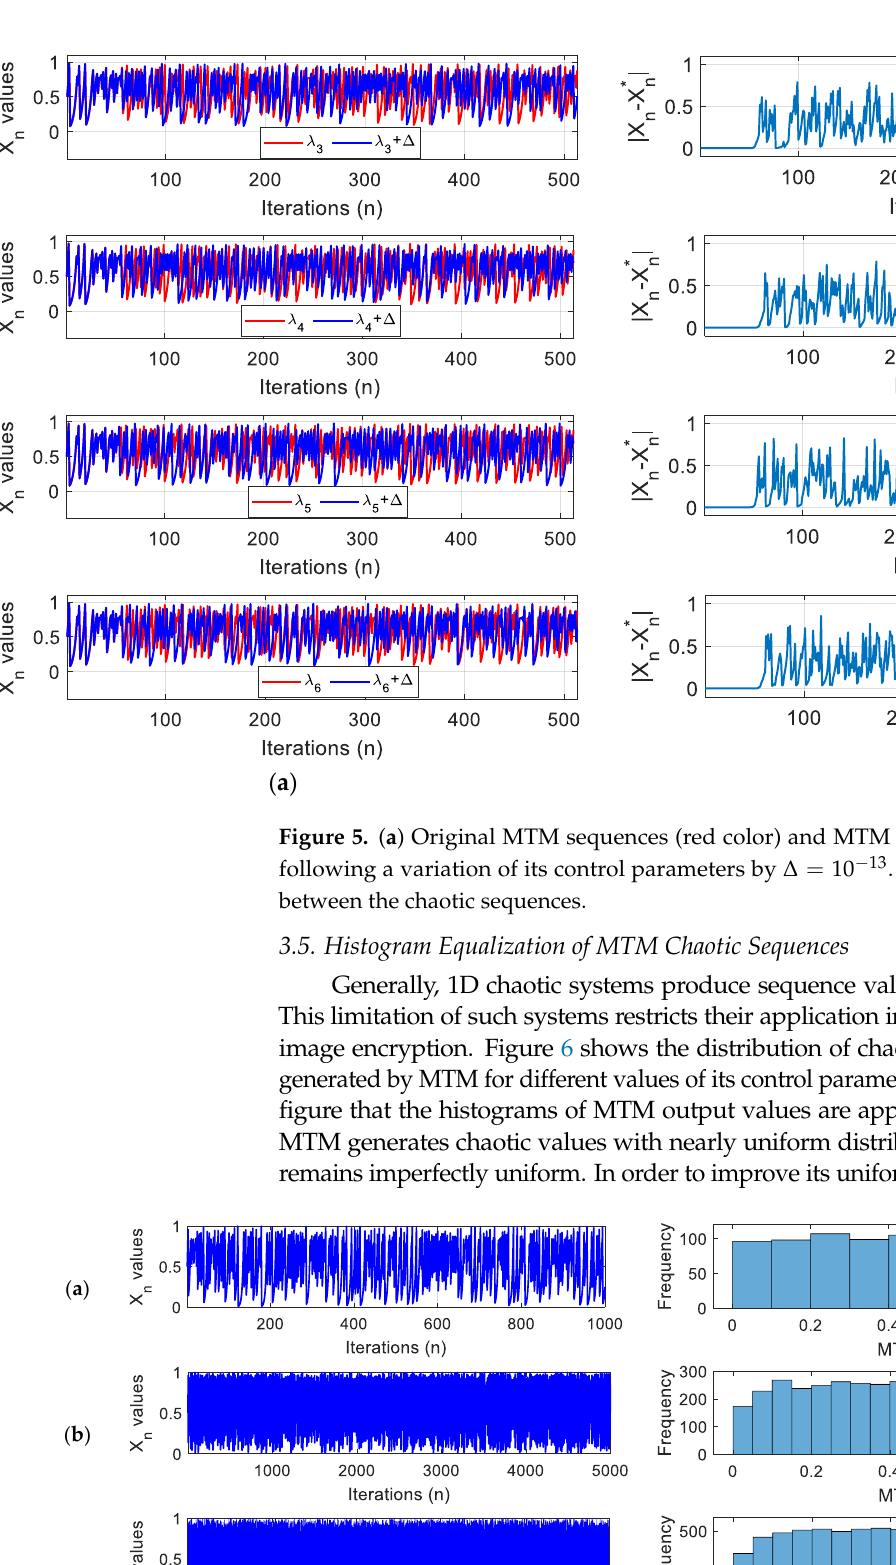
(cid:0) (cid:1) 10 − 2 ,0.5